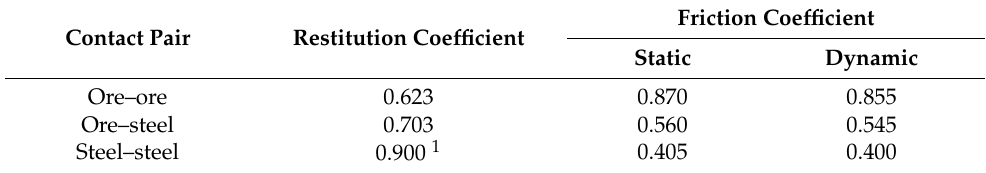
Figure 9. Section of the lining of the cylindrical part of the drum used in the simulation.